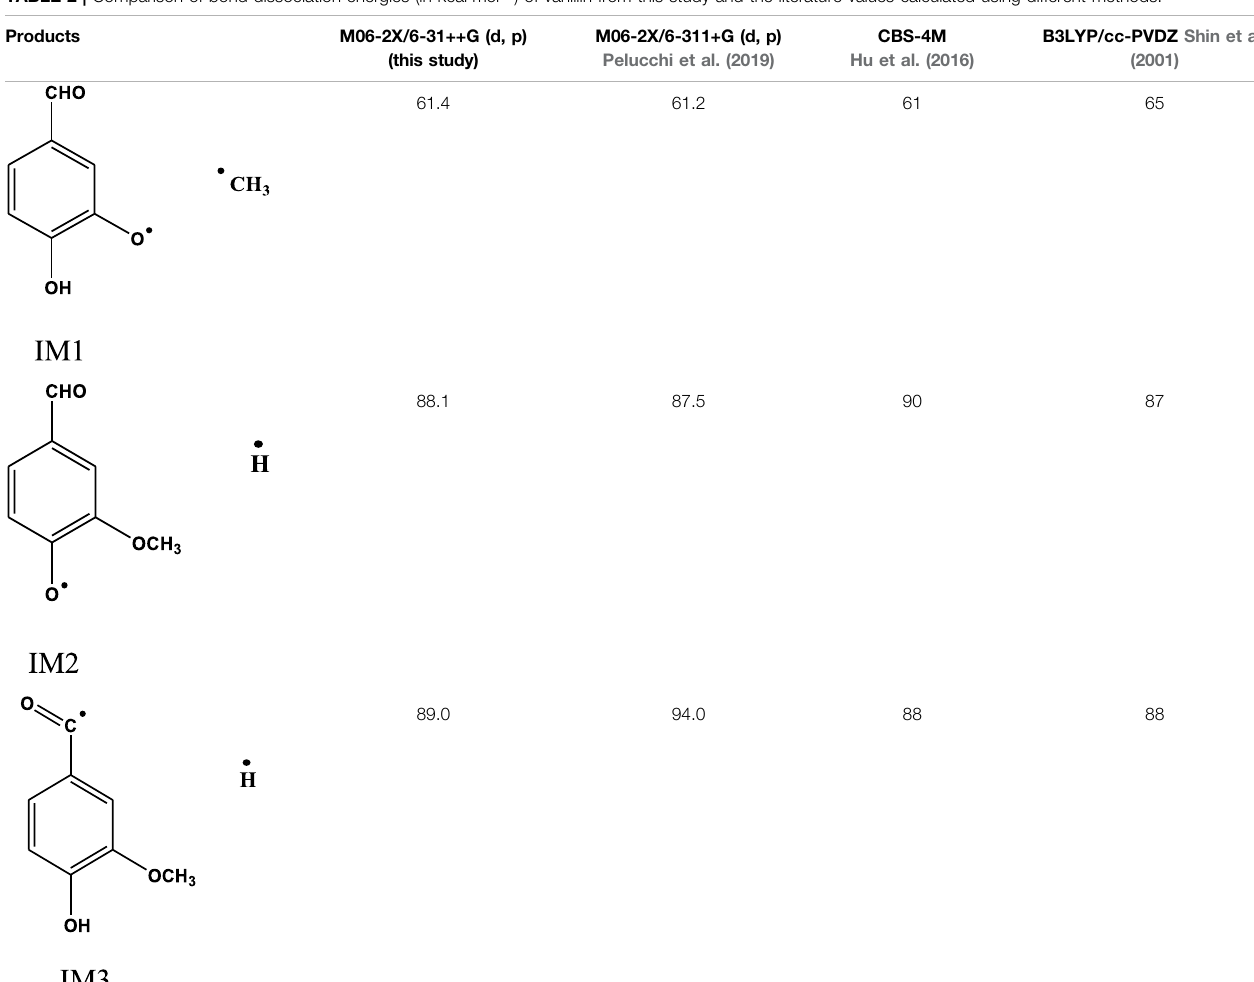
TABLE 2 | Comparison of bond dissociation energies (in kcal mol − 1 ) of vanillin from this study and the literature values calculated using different